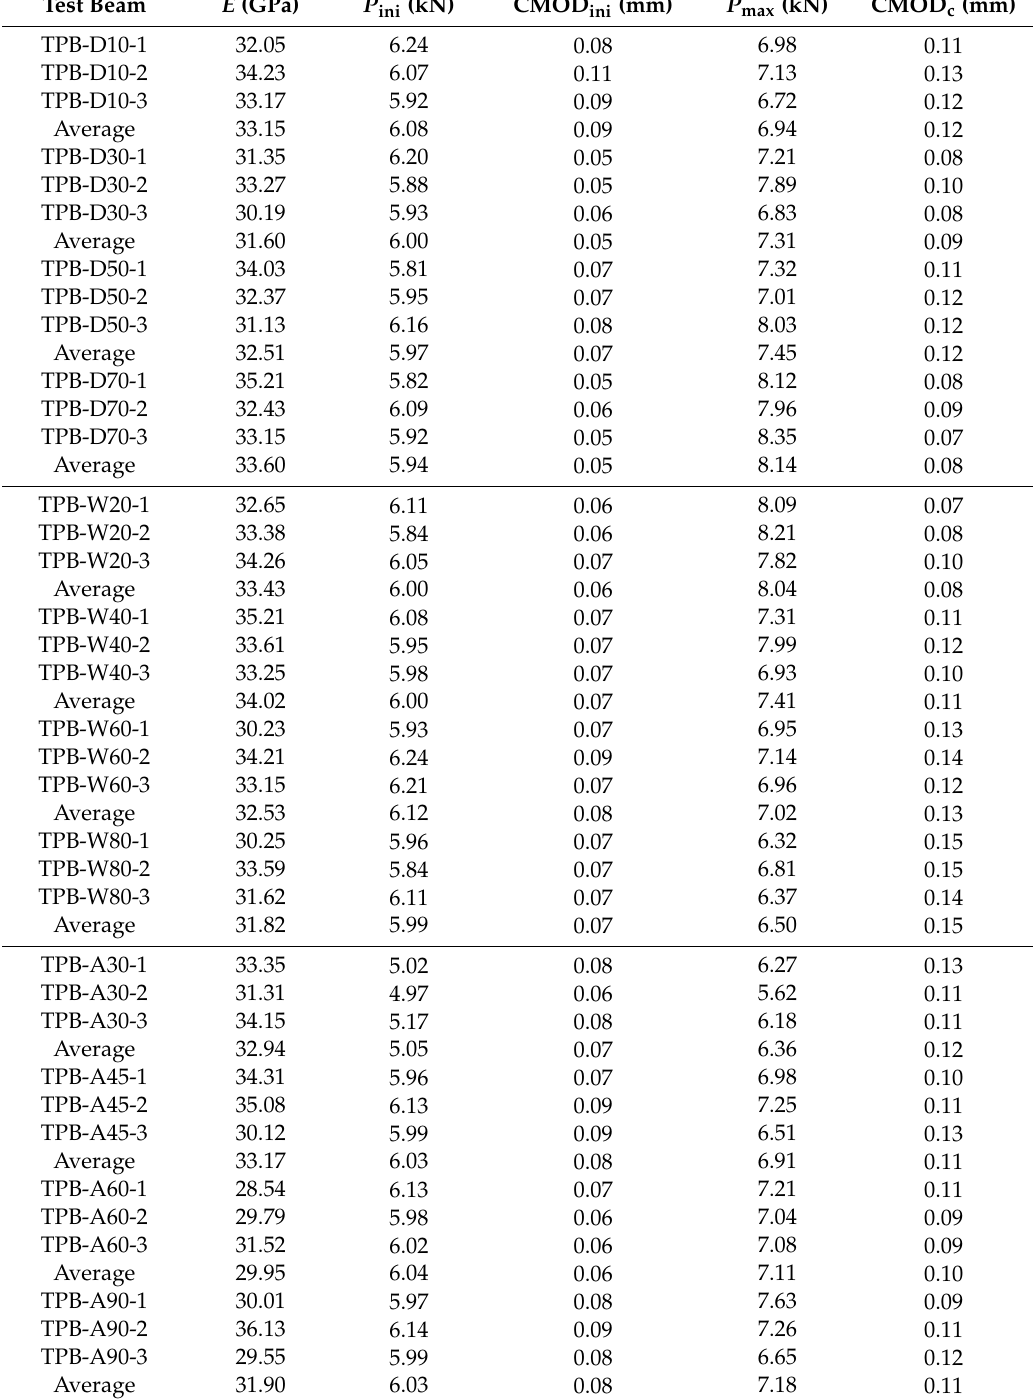
Table 3. The fracture parameters of test